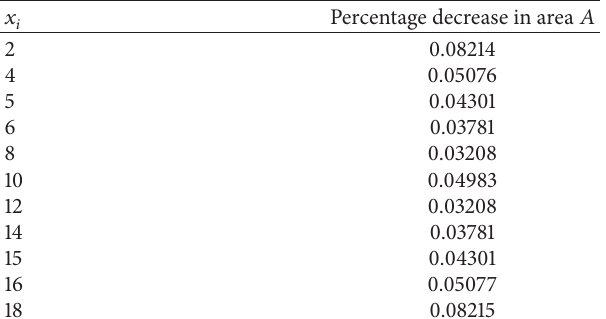
Table 1: Selected out put values for 𝑥 𝑖